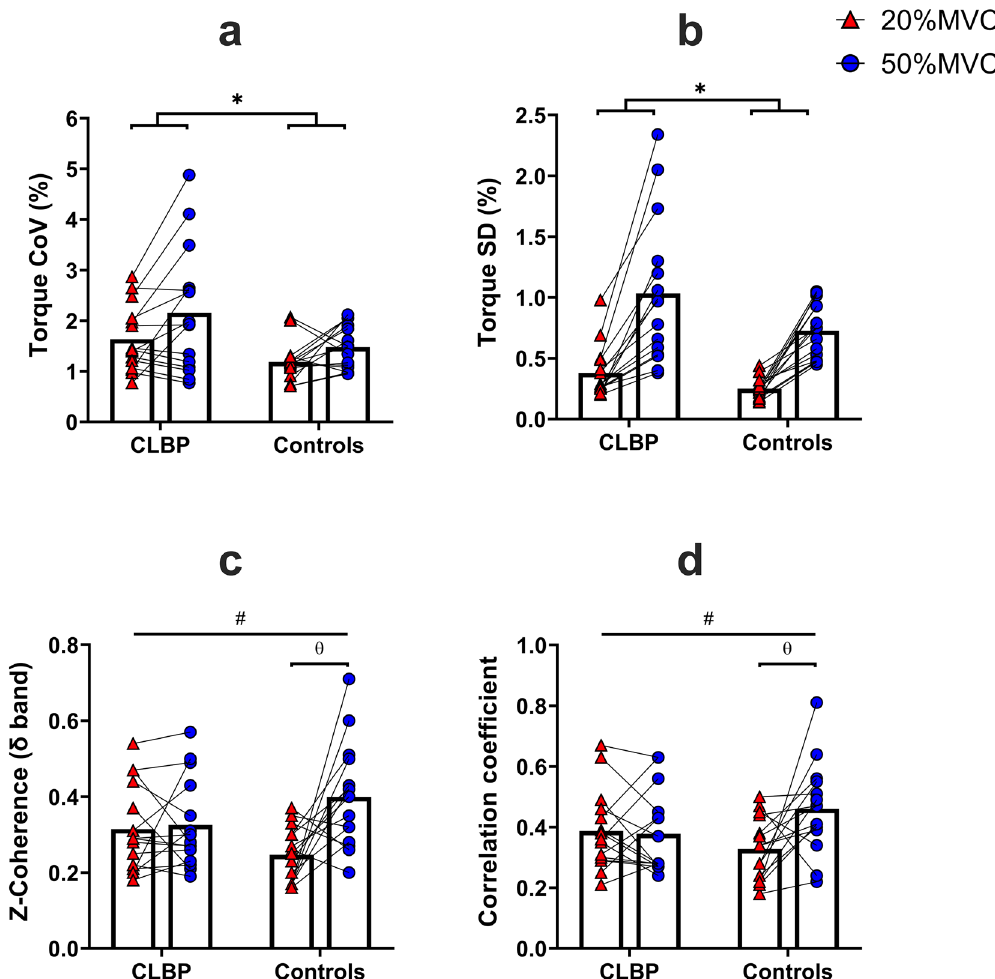
Figure 3. Torque CoV ( a ), torque SD ( b ), δ-band Z-coherence (i.e., δ band coherence values that have been transformed to z-scores) ( c ) and cross-correlation ( d ) values (mean ± SD) of the CLBP group and AS controls at 20% and 50%MVC respectively (*main effect of group, #interaction effect: group*torque, θ: post hoc